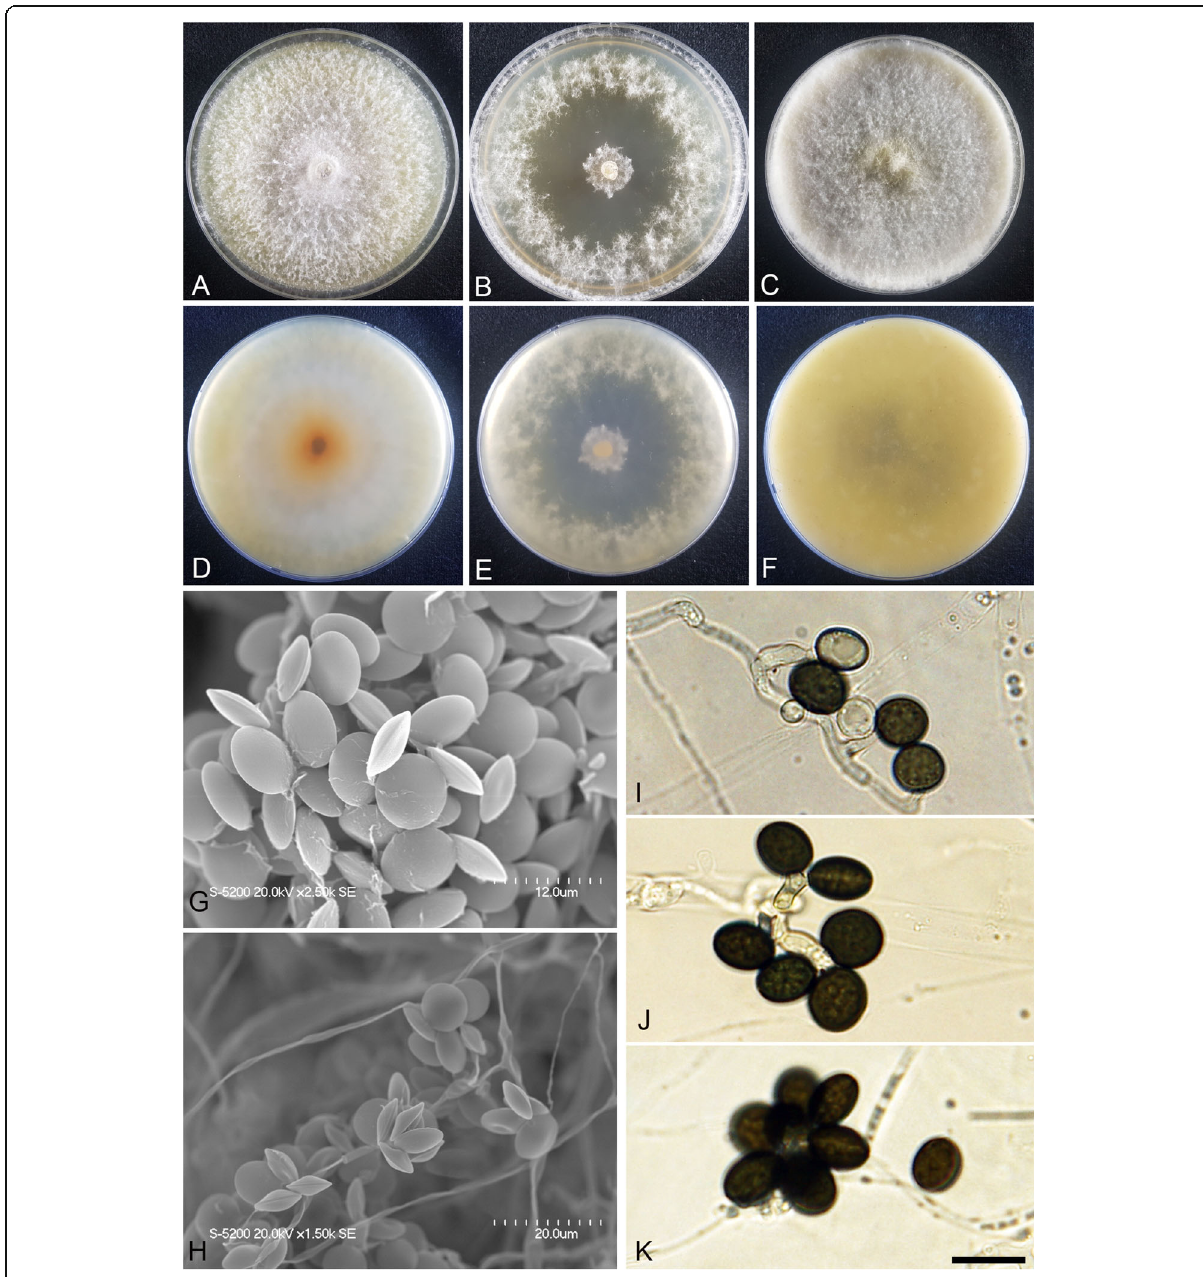
Fig. 9 Arthrinium sargassi (KUC21232). a-c , Colonies on PDA ( a ), MEA ( b ), and OA ( c ) (top); d-f , colonies on PDA ( d ), MEA ( e ), and OA ( f ) (bottom); g-h , conidia under SEM; i-k , conidia attached to conidiogenous cells; scale bar = 10 μ